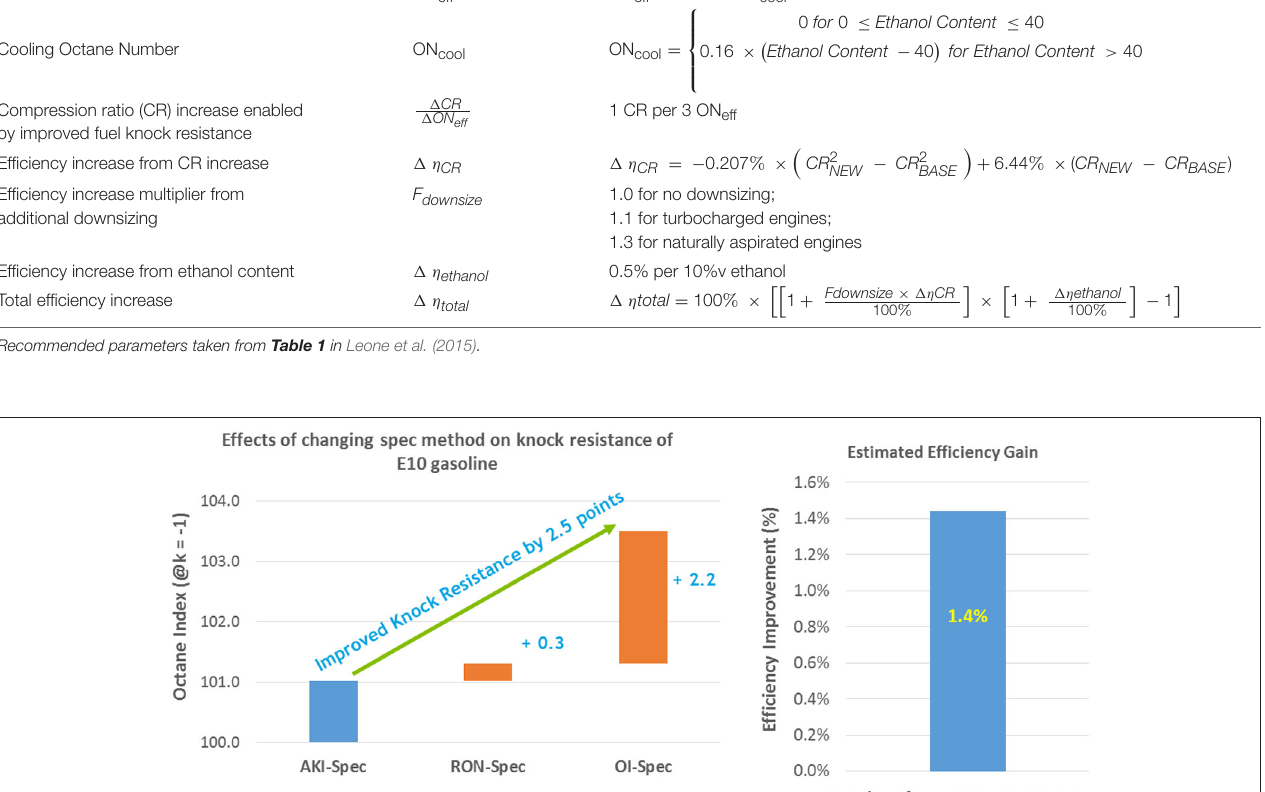
TABLE 3 | Correlations used for estimating SI engine efficiency improvements due to higher compression ratio enabled by higher octane and ethanol containing gasolines. Parameters Recommendations Effective octane number ON eff